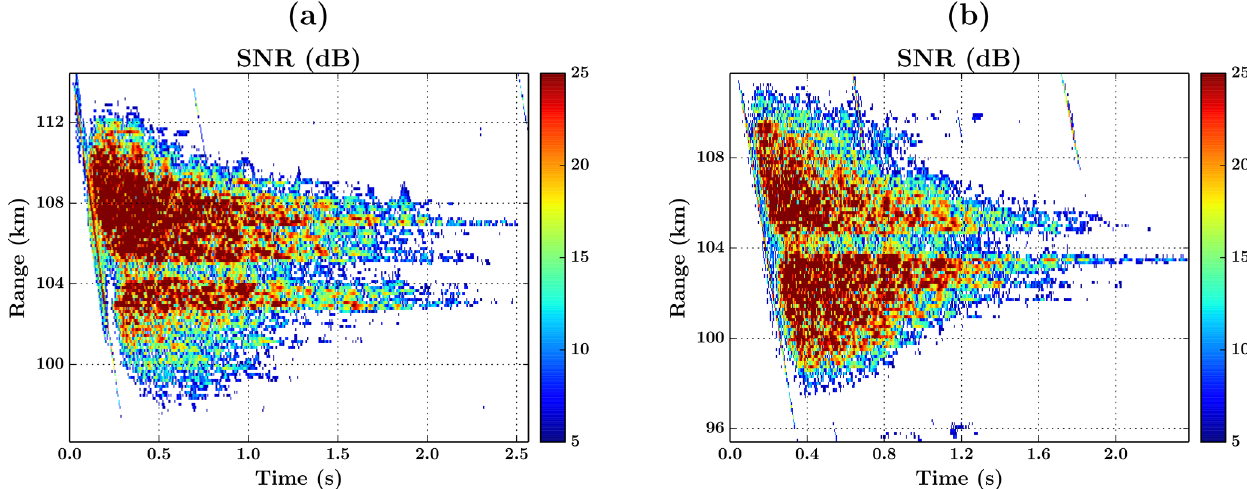
Figure 8. (a, b) show meteor trails collected with Jicamarca VHF radar at 04:46 and 04:54LT, respectively, on 5 May 2007. The meteoroid in (a) travels at 65kms − 1 , almost parallel to the east–west magnetic direction, while the meteoroid in (b) moves in the northwesterly magnetic direction at a speed of 56kms − 1 . Notice that both examples exhibit a sudden decrease in the backscatter power near 104.5km